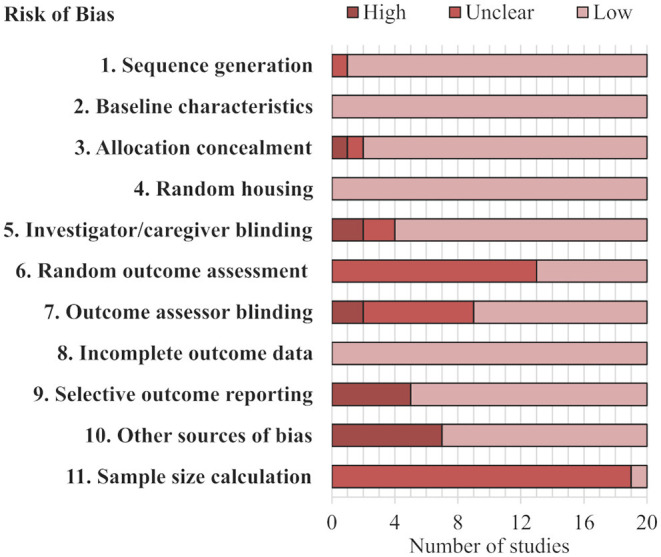
Stacked bar chart of risk of bias assessment. Each row represents a type of bias assessed for the studies. Further details can be found in Supplementary Table 1.